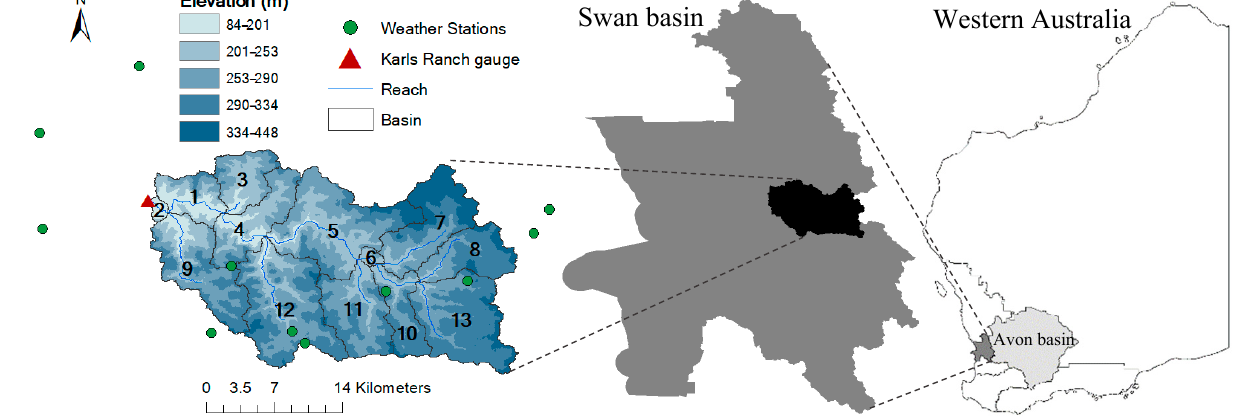
Figure 1. Location map of the Wooroloo Brook catchment (consists of 13 sub–basins).